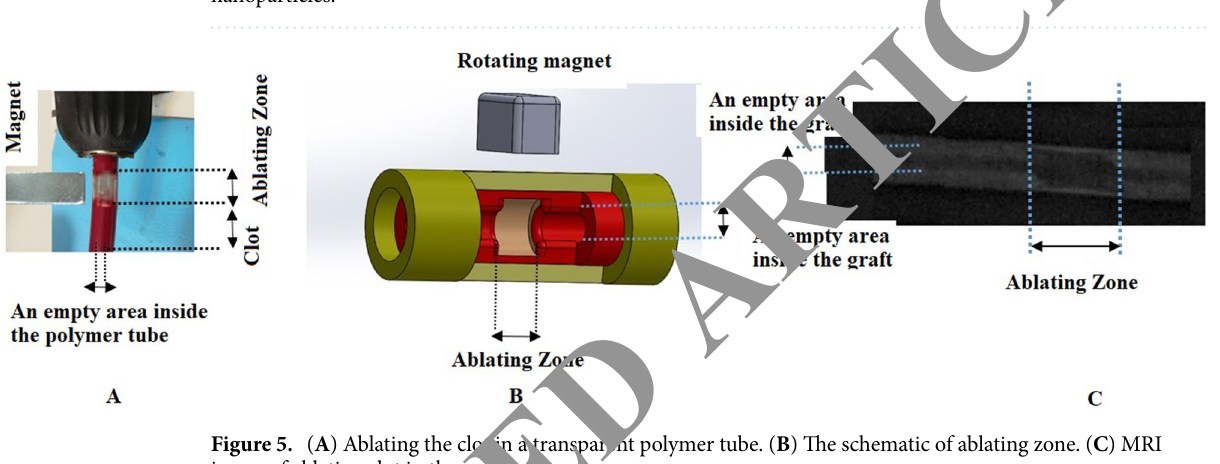
Figure 5. ( A ) Ablating the clot in a transparent polymer tube. ( B ) The schematic of ablating zone. ( C ) MRI image of ablating clot in the